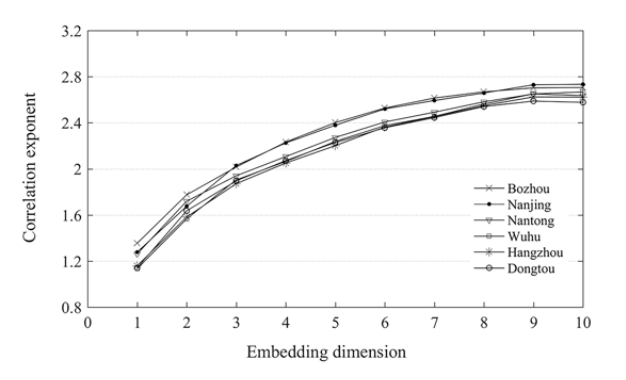
Figure 7. The plots of correlation exponent ( d ) versus embedding dimension ( m ) for the time series of annual data from the selected six meteorological stations It can be seen from the trend of the six meteorological stations in Figure 7 that, as the embedding dimension increases, the correlation exponent increases continuously and eventually stabilizes, and the saturated correlation exponent, namely, the correlation dimension, was obtained when m ≥ 10.